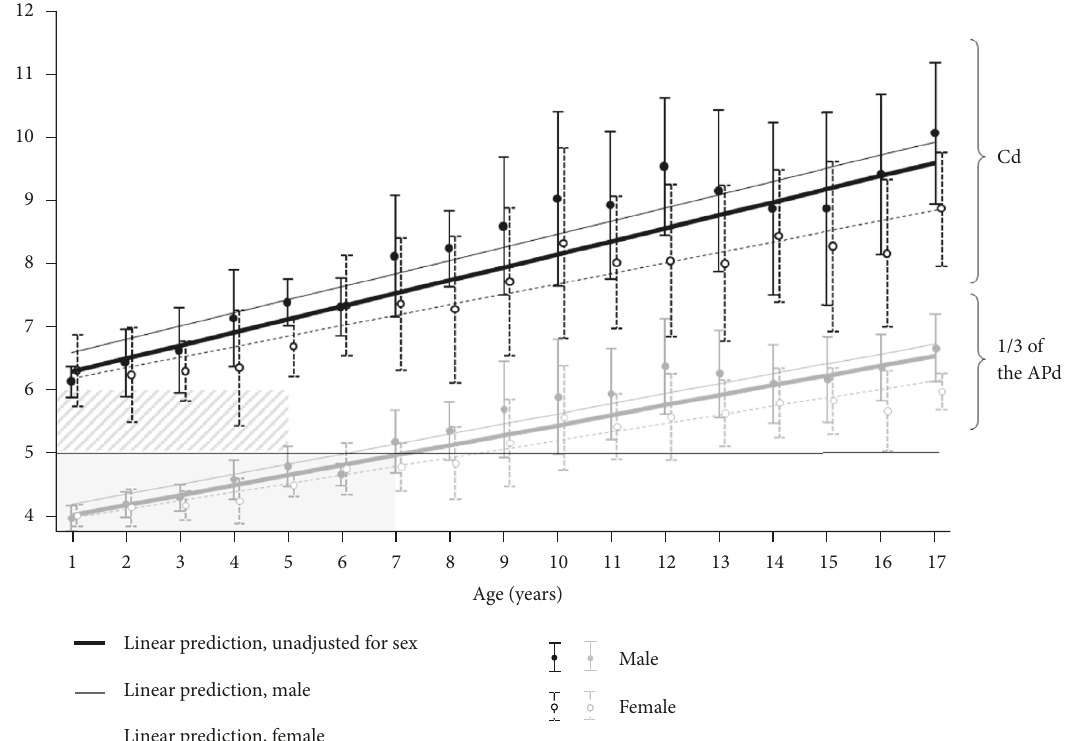
Figure 4: Linear regression analysis of Cd and 1/3 of the APd by age group among patients aged 1–18 years. Linear prediction lines (bold solid lines: unadjusted, fine solid and dotted lines: adjusted for sex) are shown with means (black circle) and standard deviations (error bars) by age. In some subjects with a Cd of less than 6 cm among 1 to 5 years of age, the residual depth is less than 1cm if chest compression is delivered by 5 cm depth (oblique-lined area). Chest compression depth is deeper when the chest was compressed by 5 cm than 1/3 of the APd in children between one to 7 years old (gray-colored area). APd: anteroposterior diameter; Cd: compressible